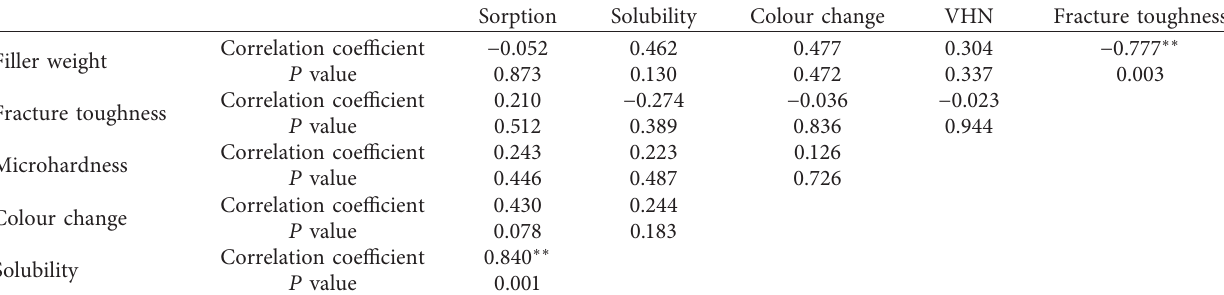
Different lowercase letters show significant difference between materials in each condition (column). Table 6: Correlations between five measured parameters by the Pearson